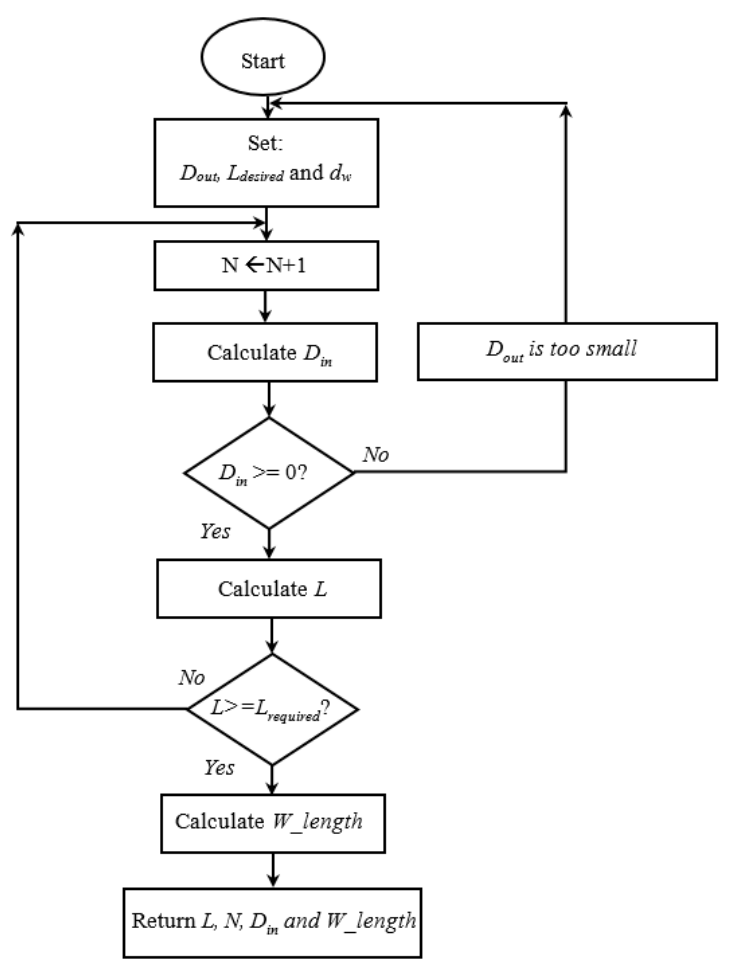
Figure 14. Flowchart of the iterative algorithm used to identify coil parameters.